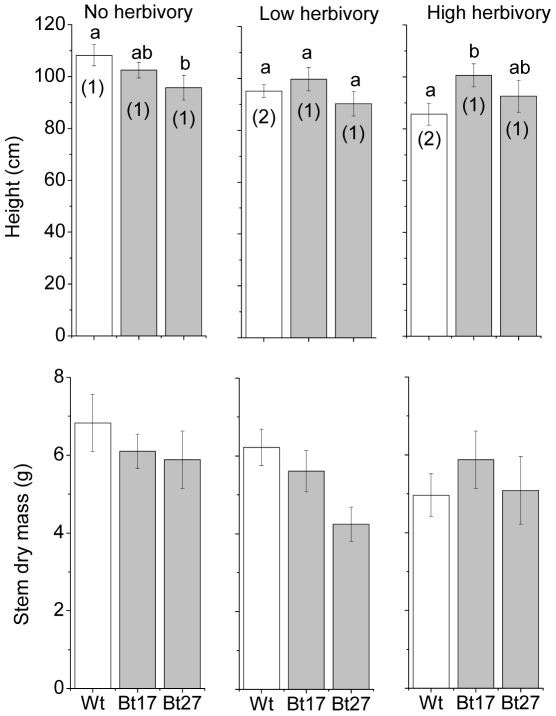
Changes in plant height and stem mass.Mean height and stem mass (and ±SE) of plants from Wt, Bt17and Bt27 lines at the end of the experiment. Bars with different letters indicate significant differences (P<0.05) among lines within the same herbivory treatment and different numbers inside the bars denote significant differences within the same line but between treatments. Please note that the ANOVA analysis revealed no significant interaction between line and herbivory for stem mass. As a result, no pair-wise statistical comparisons were conducted for stem mass and the bars therefore lack letters.